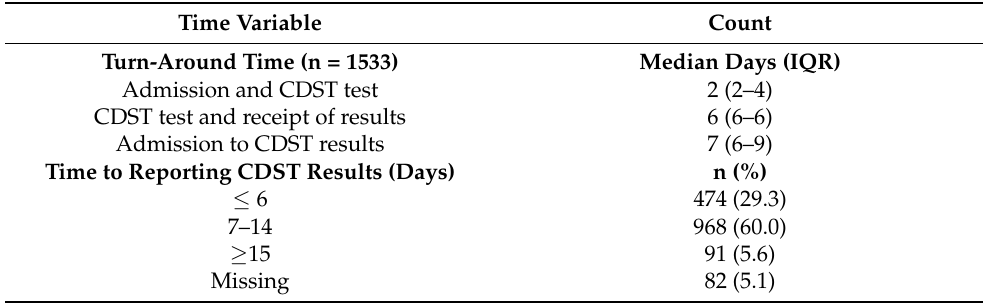
Figure 1. Flowchart on CDST uptake, bacteriological confirmation, resistance to first-line antibiotics, and outcomes among neonates with clinically suspected sepsis admitted to the NICU of two tertiary care hospitals in Yangon, Myanmar from January 2017 to December 2019. CDST = culture and drug susceptibility testing; NICU = neonatal intensive care unit; LAMA = Left against medical advice; DoR = discharge on request. * First line antibiotics-ampicillin, amikacin, gentamicin, and cefotaxime. Table 3. Turn-around time of CDST among neonates with clinically suspected sepsis admitted to the NICU of two tertiary care hospitals in Yangon, Myanmar, January 2017 to December